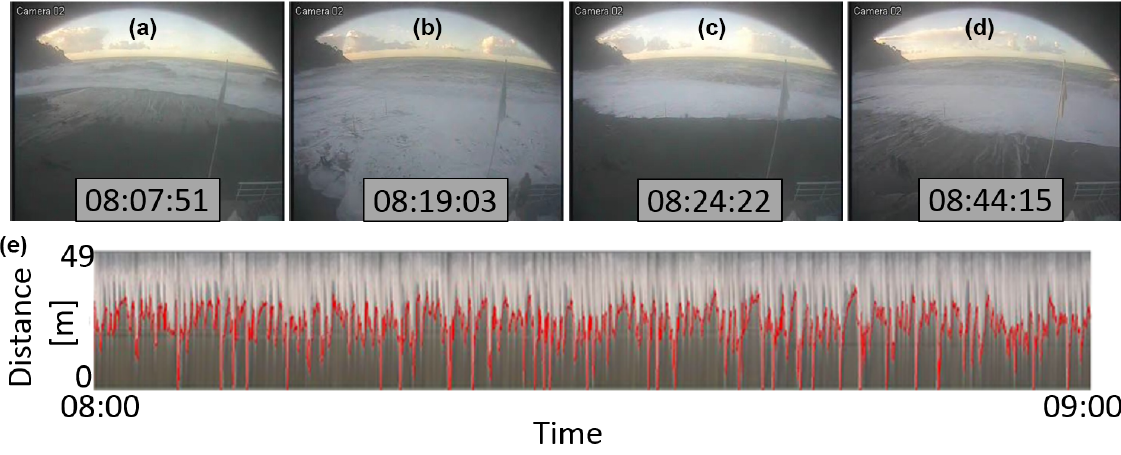
Figure 6. A time sequence (a) , (b) , (c) , (d) of the Bonassola beach sea storm recorded by camera from 08:00 to 09:00UTC on 10 Febru- ary 2016; (e) timestack obtained by analyzing the video camera acquisitions in the time interval from 08:00 to 09:00UTC relative to 10 Febru- ary 2016, highlighting with a red line the detected run-up